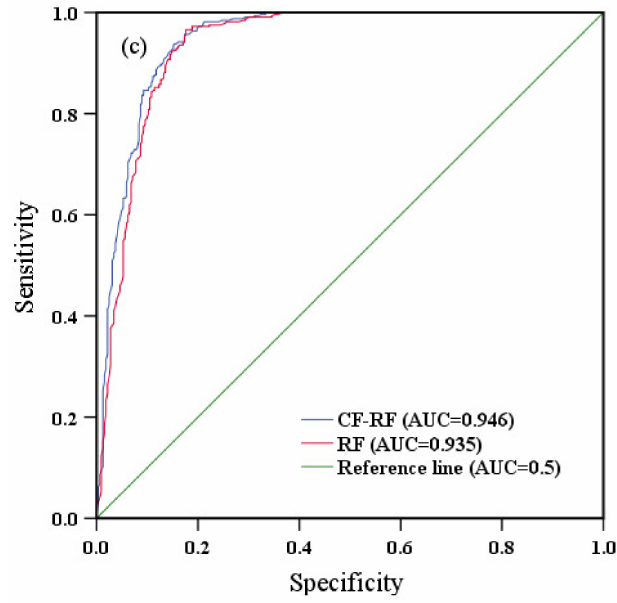
Figure 8. ROC curves with associated AUC values versus validation set: ( a ) CF-LR and LR; ( b ) CF-SVM and SVM; ( c ) CF-RF and